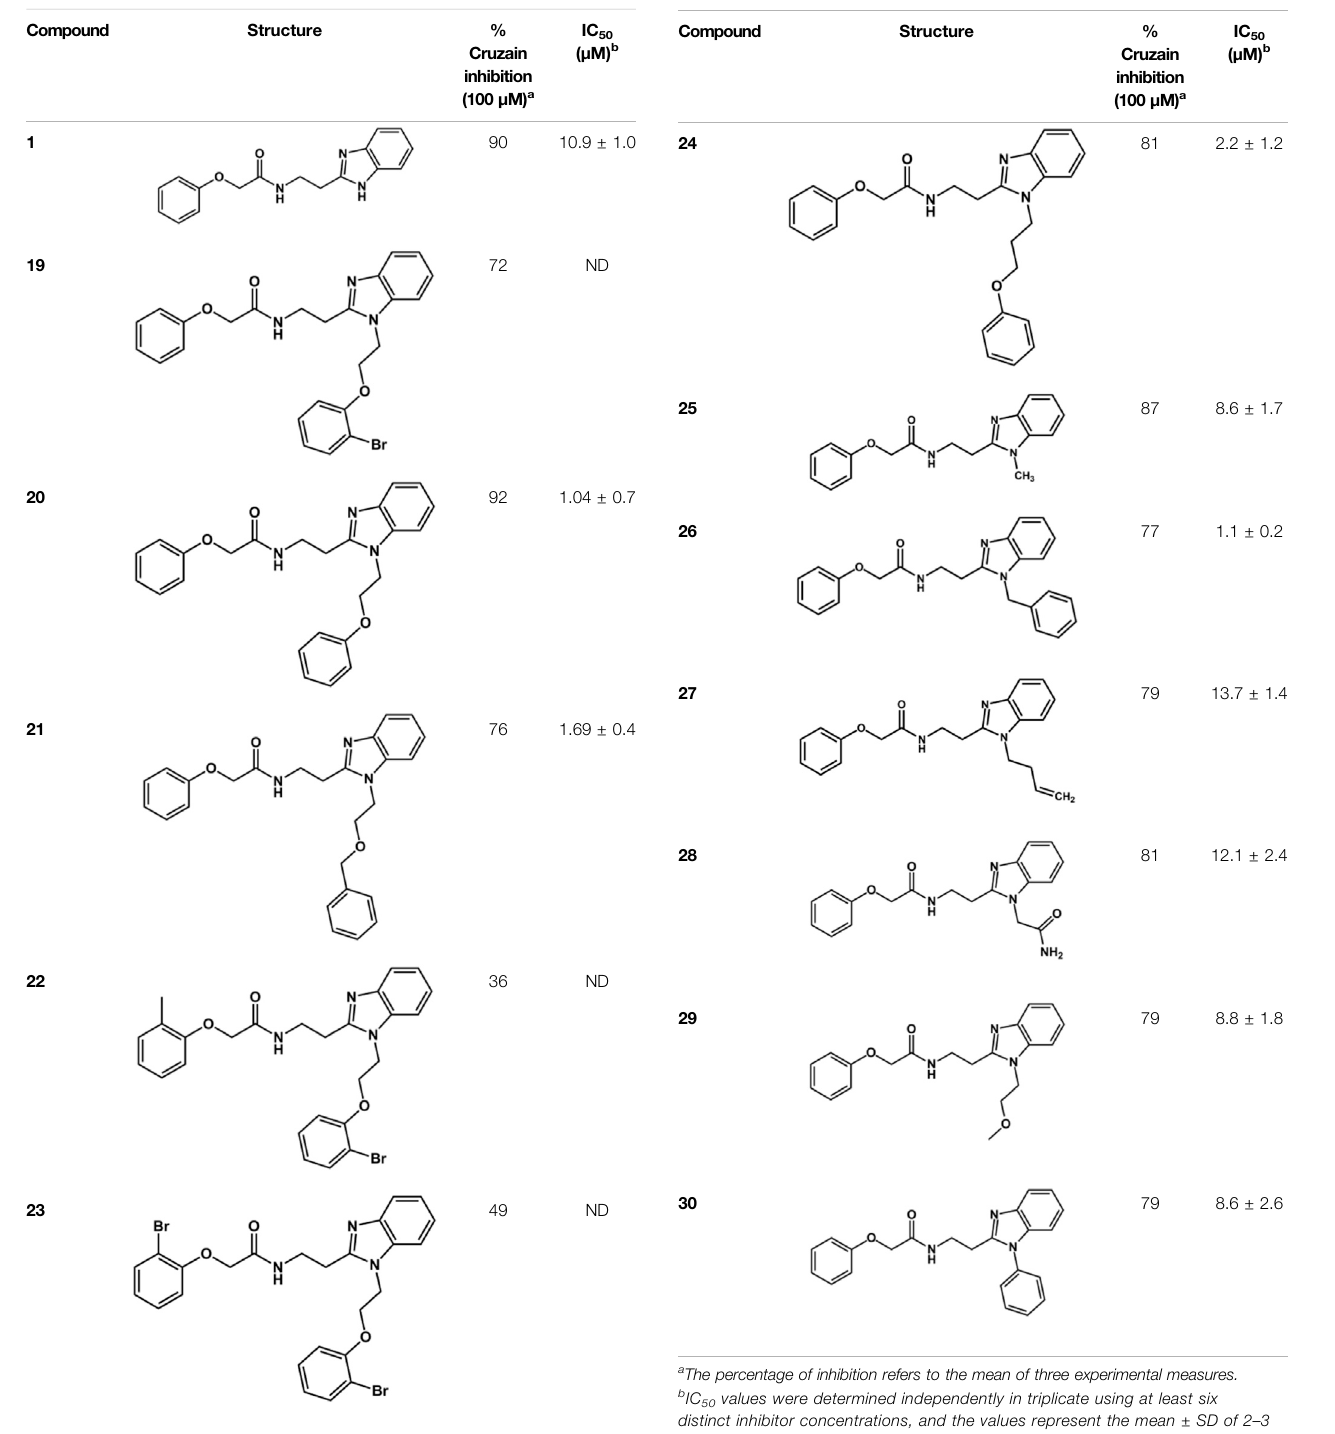
TABLE 1| ( Continued )Structure and activity against cruzain ofnew N -substituted benzimidazole derivatives.